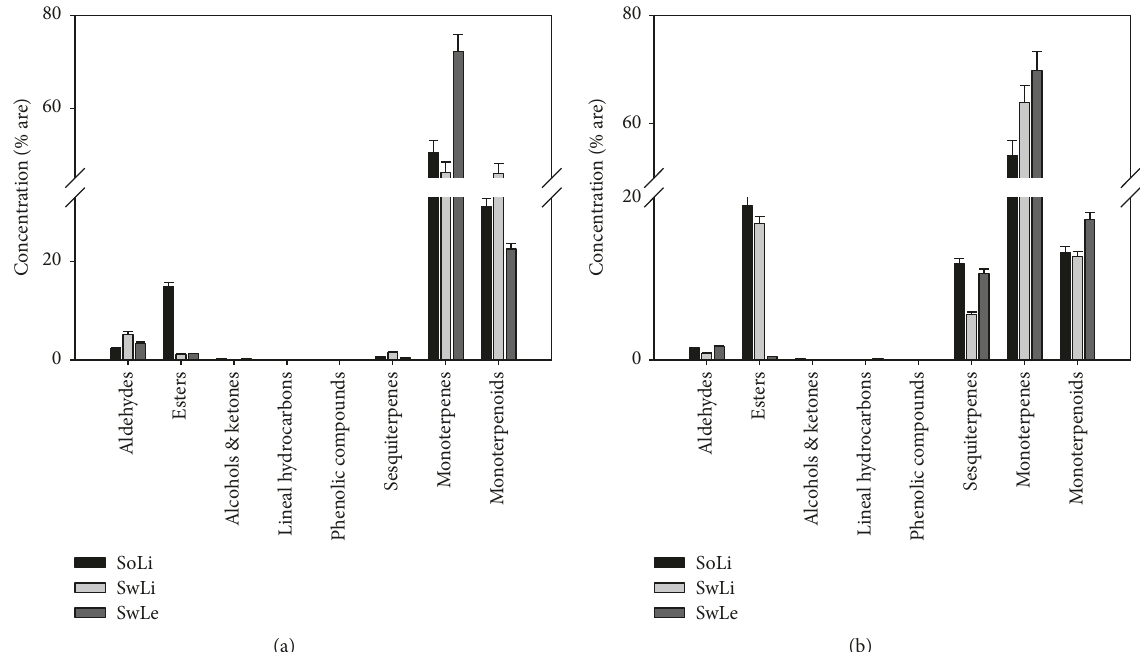
Figure 1: Total concentration (% area) of each chemical family of volatile compounds in the juice (a) and peel (b) of endangered Spanish lime and lemon